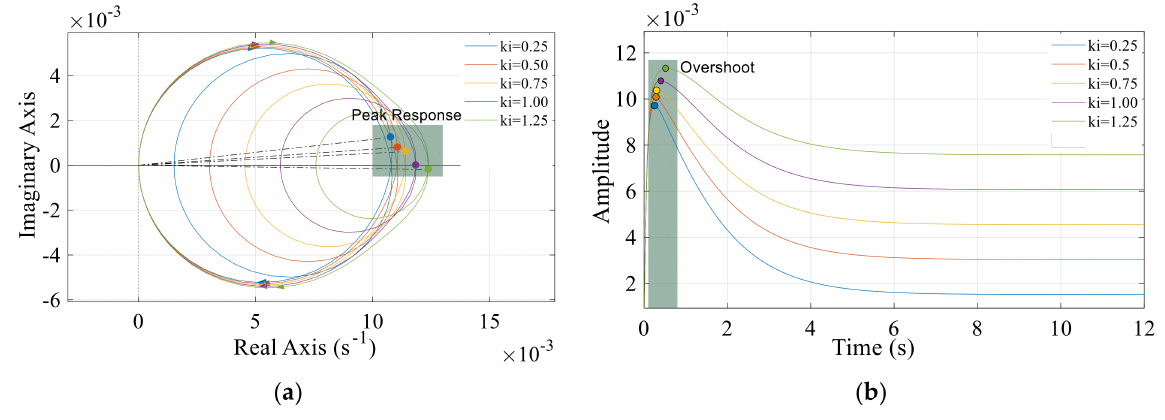
Figure 14. Nyquist and step responses to the variation of the integral adjustment coefficient, k i = [0.25, 1.25]. ( a ) Nyquist response, and ( b ) step response.